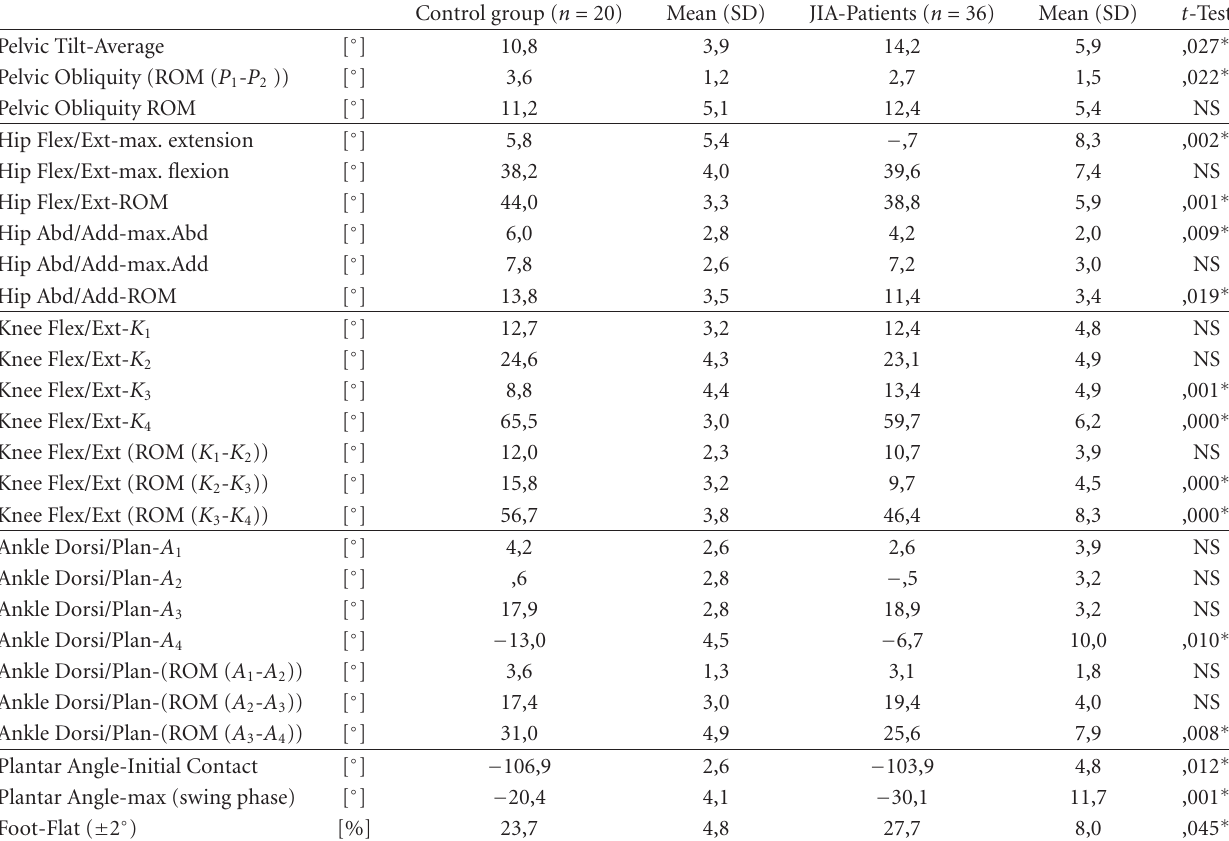
Table 2: Kinematic parameters in pelvis, knee, and ankle Joint ( ∗ : statistically significant; NS: not significant). Control group ( n = 20) Mean (SD) JIA-Patients ( n =